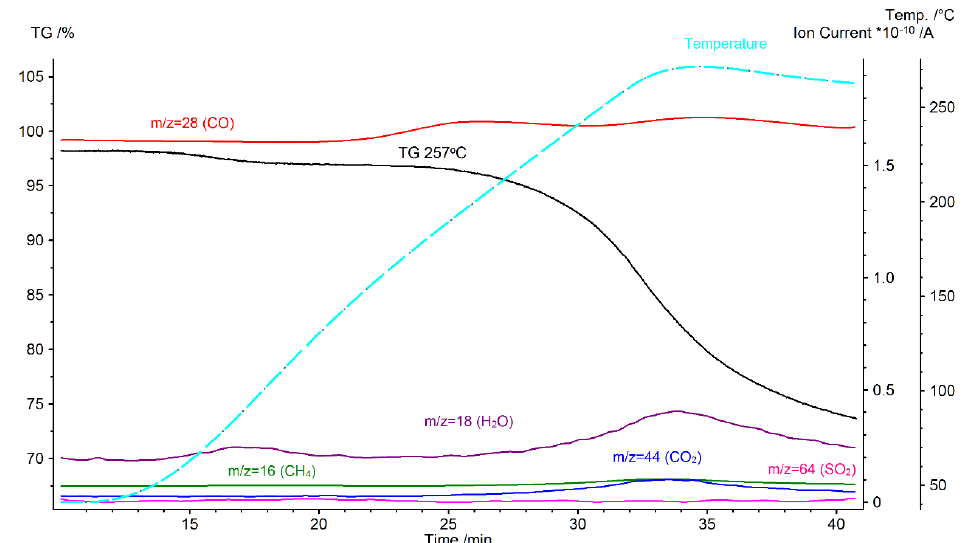
Figure A9. TG curve and ion current curves for the oat straw torrefaction process carried out up to 257.5 °C.